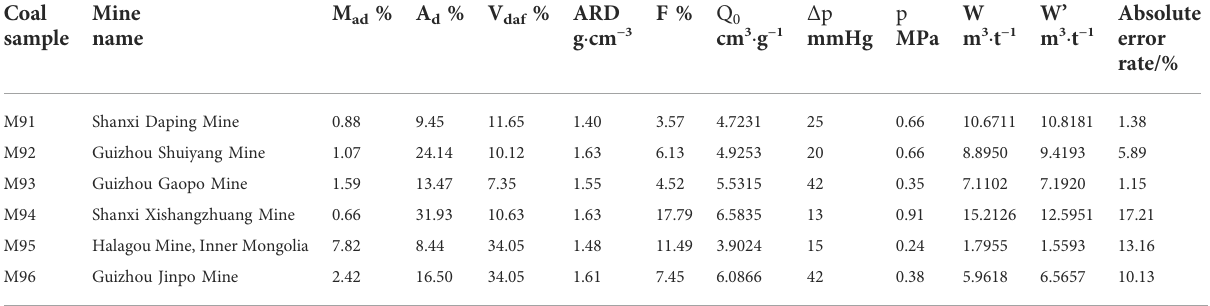
TABLE 3 Comparison of the deviation between the predicted value and measured value of coal seam gas content. Coal Mine sample